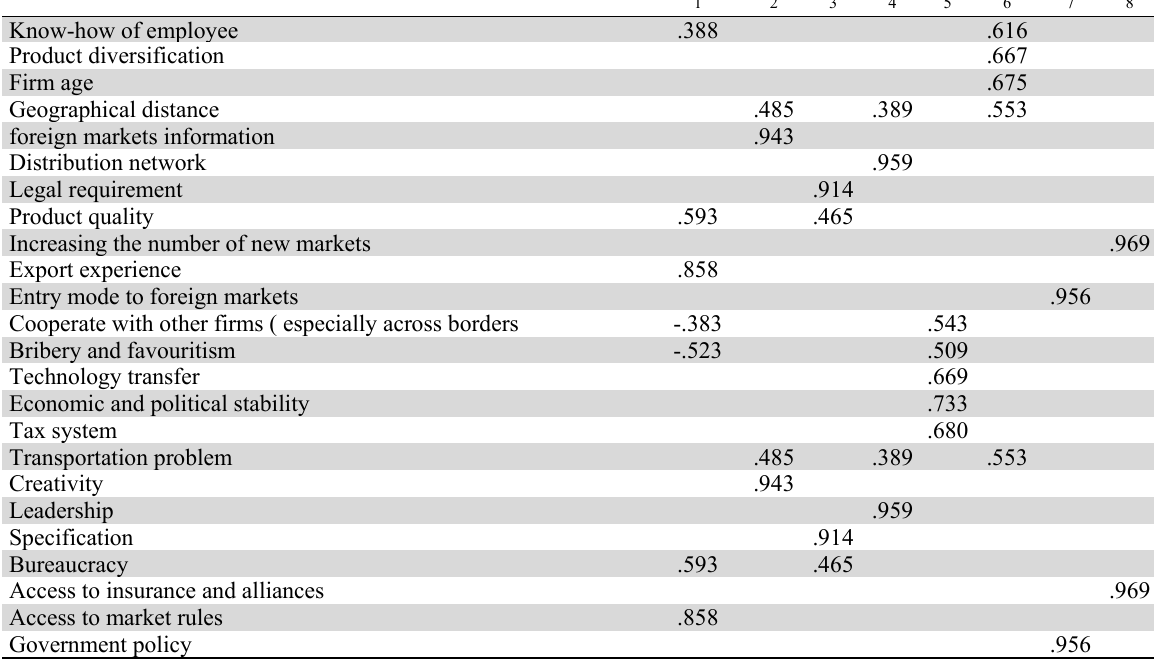
The results of principle component analysis using Varimax